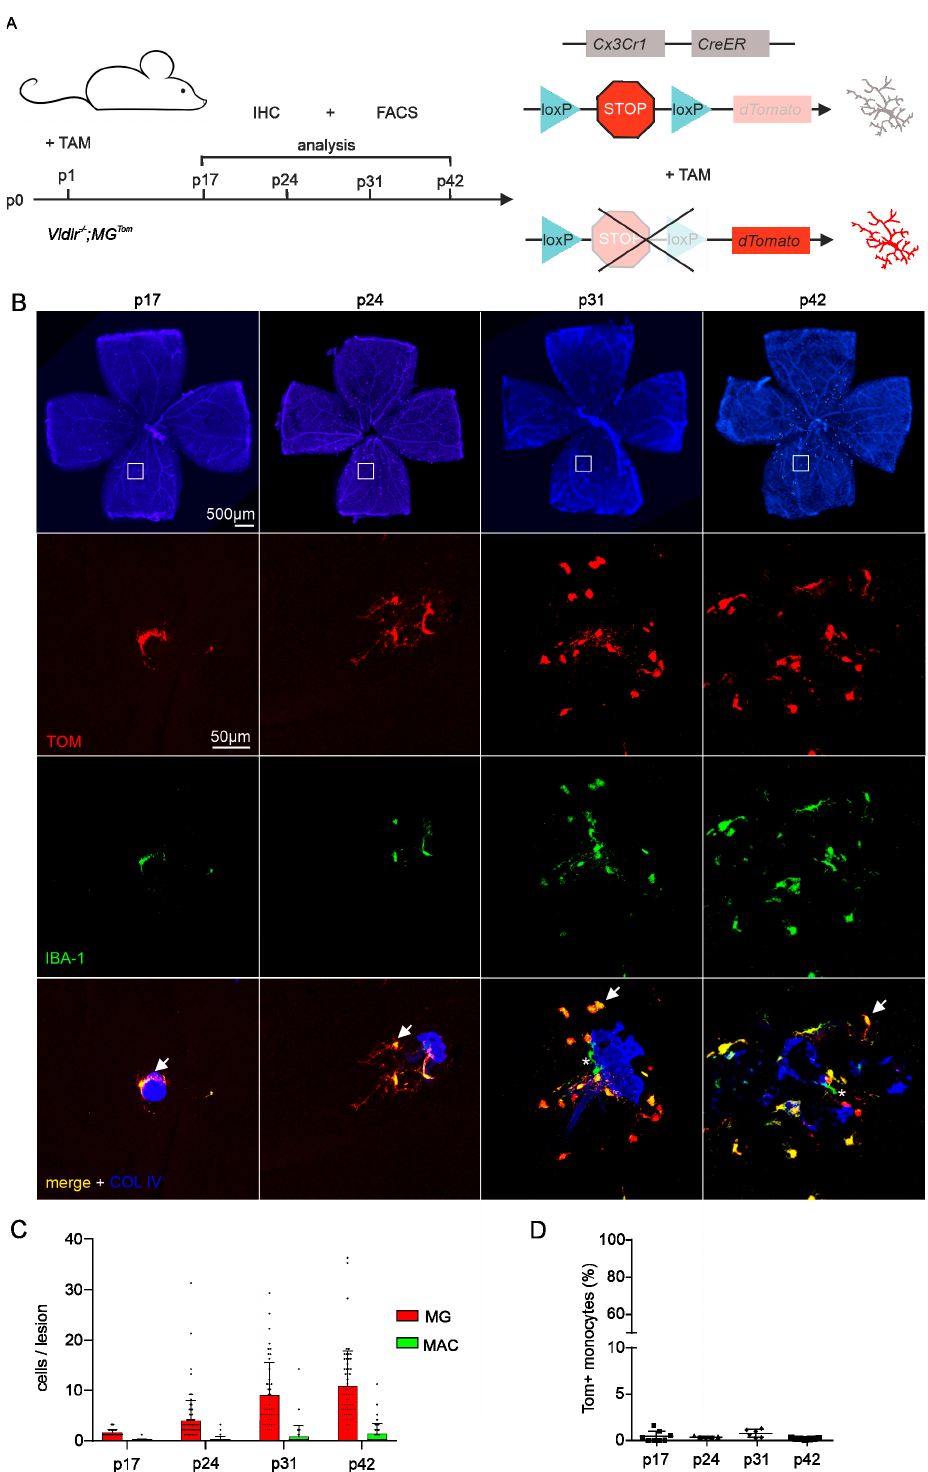
Figure 2. Distributional profiling of retinal microglia and blood-derived macrophages during retinal angiomatous proliferation ( A ) Scheme displaying the experimental setup and timeline (left-hand side panel) for induction of reporter expression (right-hand side panel). Newborn Vldlr − / − ; MG Tom mice were injected with tamoxifen (TAM) on postnatal day (p)1. Flow cytometry (FACS) and immunohistochemistry (IHC) were performed at p17, p24, p31 and p42, respectively. ( B ) Upper panel: Retinal flat-mount stained for Collagen IV (COLIV, blue) demonstrating areas of retinal angiomatous proliferation (RAP), at p17, p24, p31 and p42, the areas within the white boxes are shown in higher magnification below: Representative confocal microscopy images of retinal angiomatous proliferation (COLIV, blue) and accumulating retinal microglia (defined as